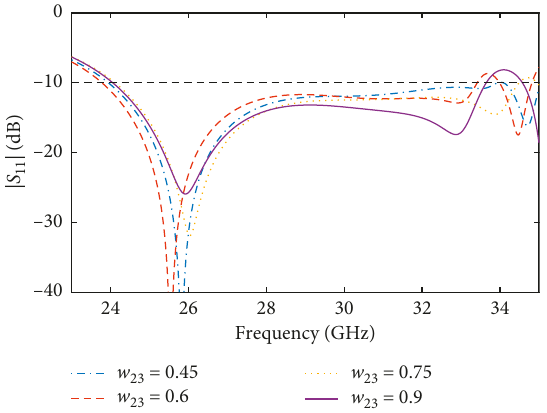
Figure 8: Effects of various w